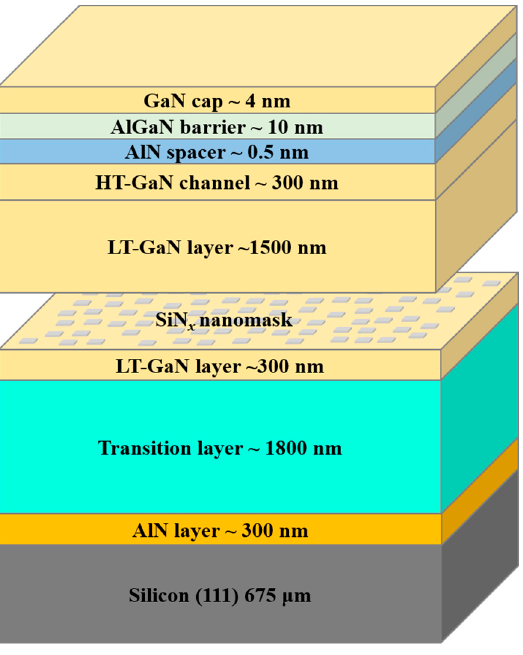
Figure 1. Schematic structure of GaN-based HEMT with inserted SiN x nano-masks grown at different SiH 4 flow rates.